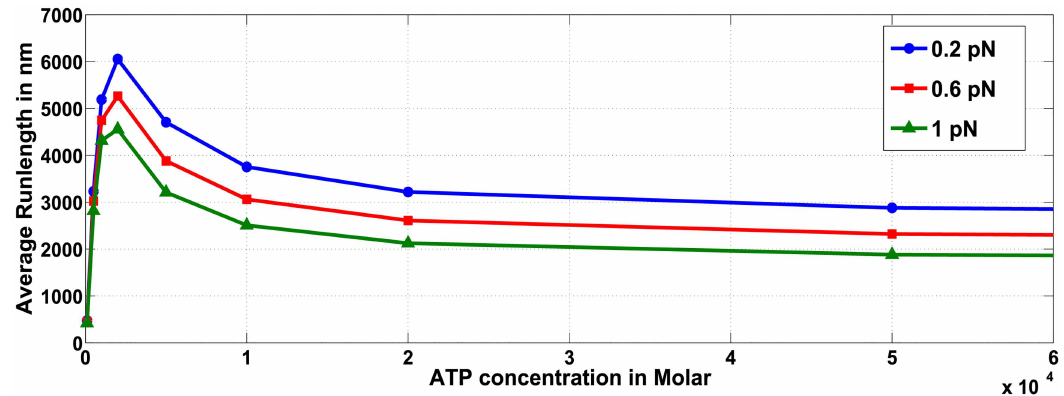
Fig 15. Effect of ATP concentration on run-length for ensemble WM, for various hindering load forces on the cargo.